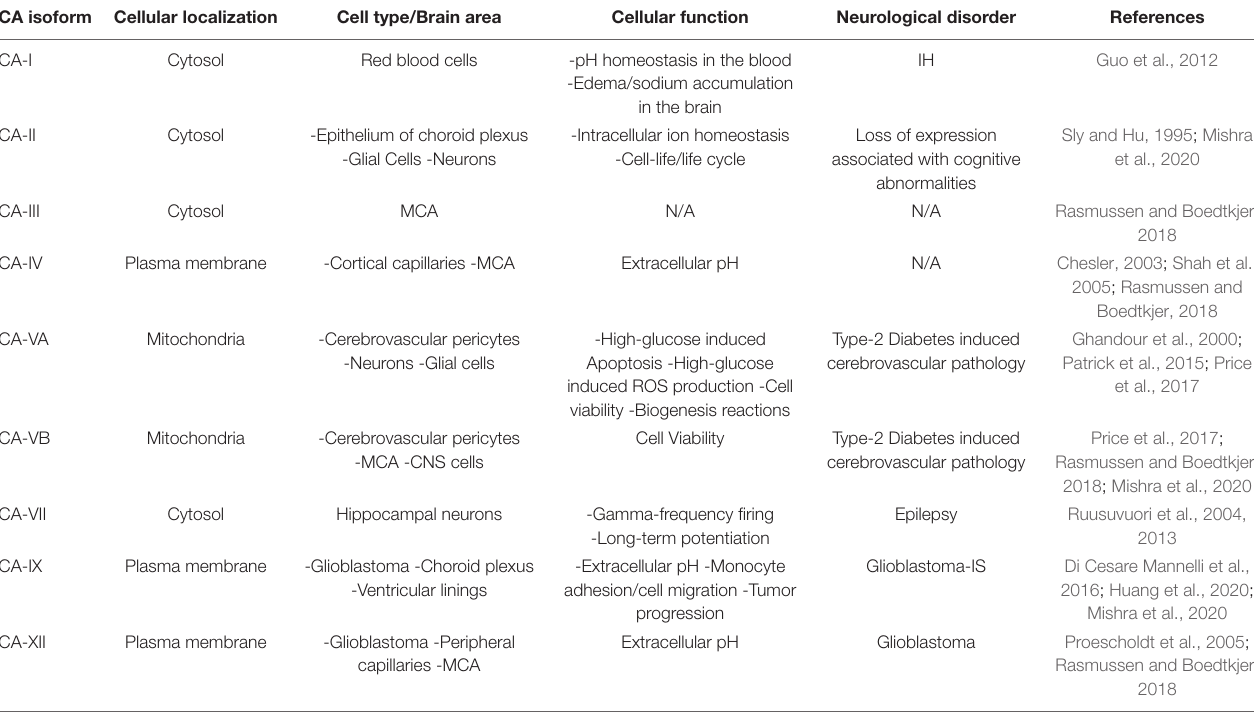
TABLE 4 | CA isoforms in CNS and cerebrovascular